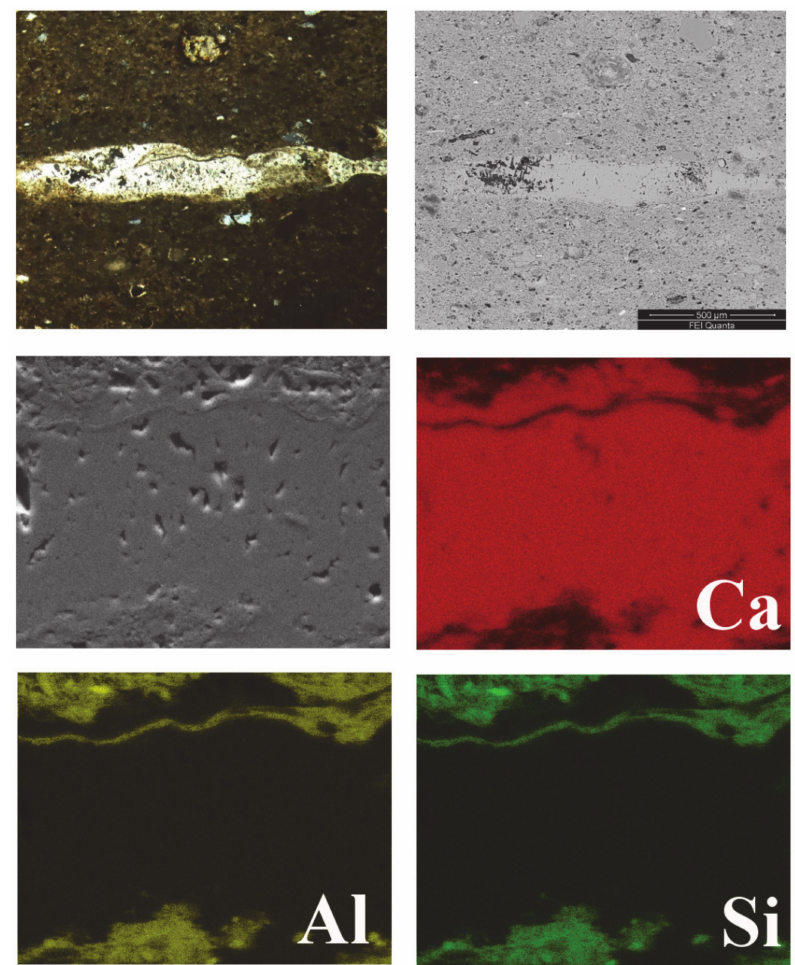
Figure 3. Optical microscopy (OM) and Back Scattered Electron (BSE) images of destabilized calcareous inclusion. Secondary Electron (SE) image and X-ray maps of the reaction rim (sample